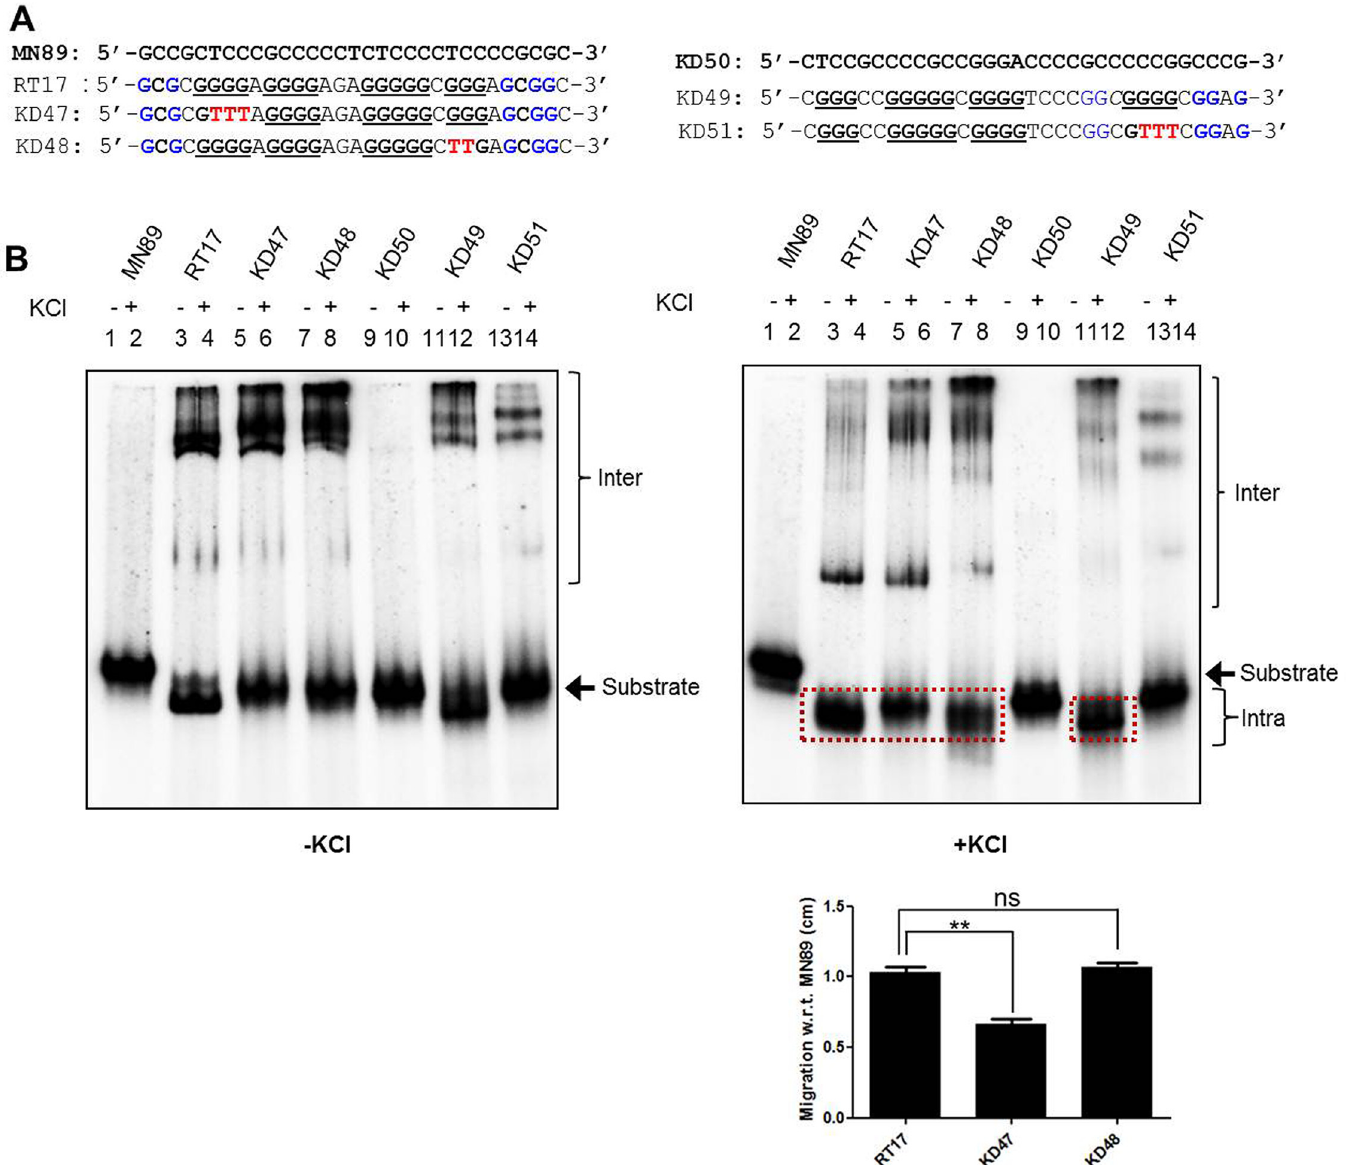
Fig 6. Evaluation of different genomic sequences harboring guanine stretches and GNG motifs for their ability to fold into G-quadruplex structures. (A) The oligomeric DNA spanning portion of HIF1 alpha promoter and VEGF promoter. In both the cases, G-rich strand (RT17 and KD49 are from HIF1 alpha and VEGF , respectively), its mutants (KD47 and KD48 are RT17 mutants; KD51 is the mutant of KD49) and complementary C-rich strand (MN89 and KD50 are reverse complement of RT17 and KD49, respectively) are depicted. In the case of HIF1 alpha the mutations were made in the first and the fourth G stretch sequence, while it was the fourth G stretch in the case of VEGF sequence. (B) Native PAGE profile showing inter and intramolecular G- quadruplex formation at HIF1 alpha promoter and VEGF promoter. The G- and C-rich strands along with the mutants were incubated in the presence (+) or absence (-) of KCl (100 mM) and resolved in the absence (left panel) or presence (right panel) of KCl (100 mM). For other details, refer Fig 1 legend. The bar diagram at the lower portion of the right panel represents relative migration of the boxed bands for RT17, KD47 and KD48 with respect to